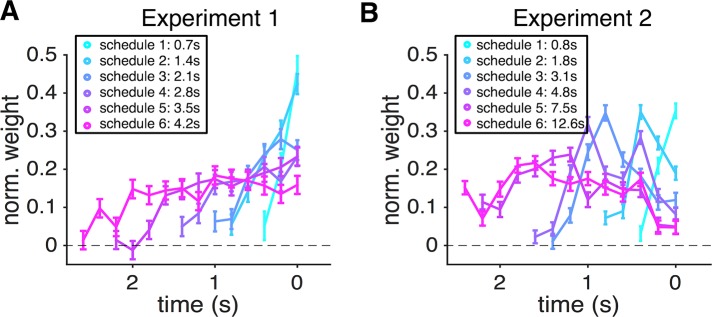
More recent samples had a stronger influence on choice in Experiment 1 but not in Experiment 2.The estimated weights of sample on choice are plotted as a function of time for Experiments 1 (A) and 2 (B), separately for different schedules. In Experiment 1, the influence of sensory evidence on choice dropped to zero on a timescale much shorter than the deadline in a given schedule. In Experiment 2, the most recent sensory evidence did not have the maximal influence on choice except in schedule 1.